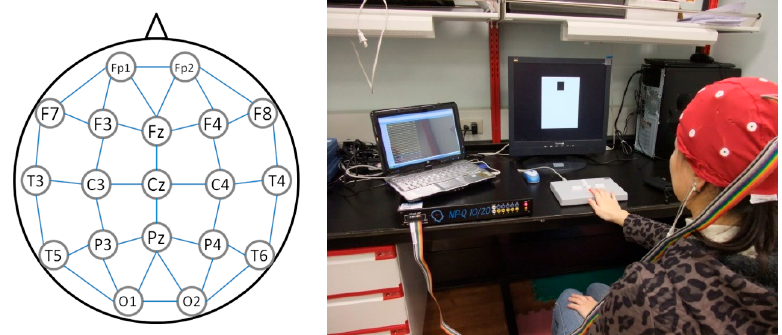
Figure 2. Electrode layout and experimental setup for the Test of Variables of Attention.